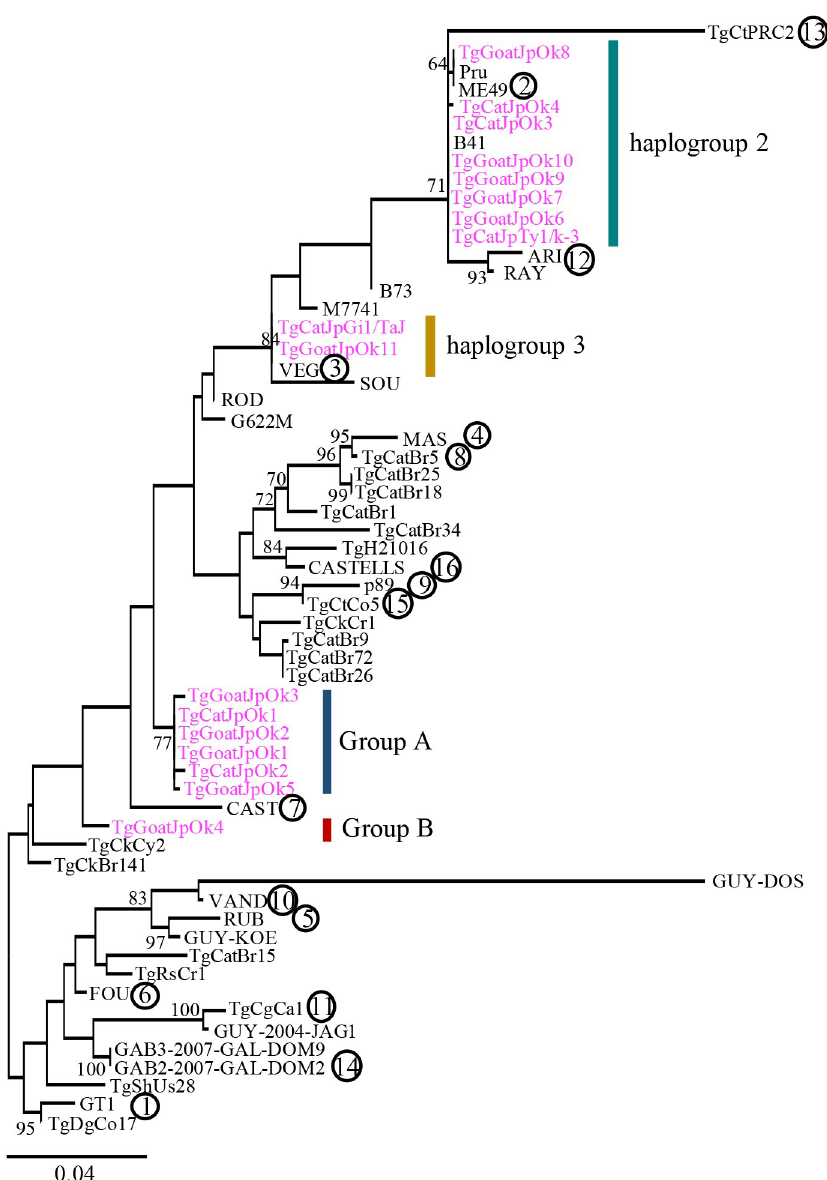
Fig 1. Phylogenetic analysis of Japanese wild isolates of T . gondii . Maximum likelihood analysis was performed using 3 genes and 3 intron sequences from 17 Japanese isolates and strains of 16 haplogroups. The number in the circle indicates representative strains of haplogroups. Detail information of other isolates is shown in S2 Table. Bootstrap value (BP) more than 60% is shown at nodes. Japanese isolates are shown in magenta.